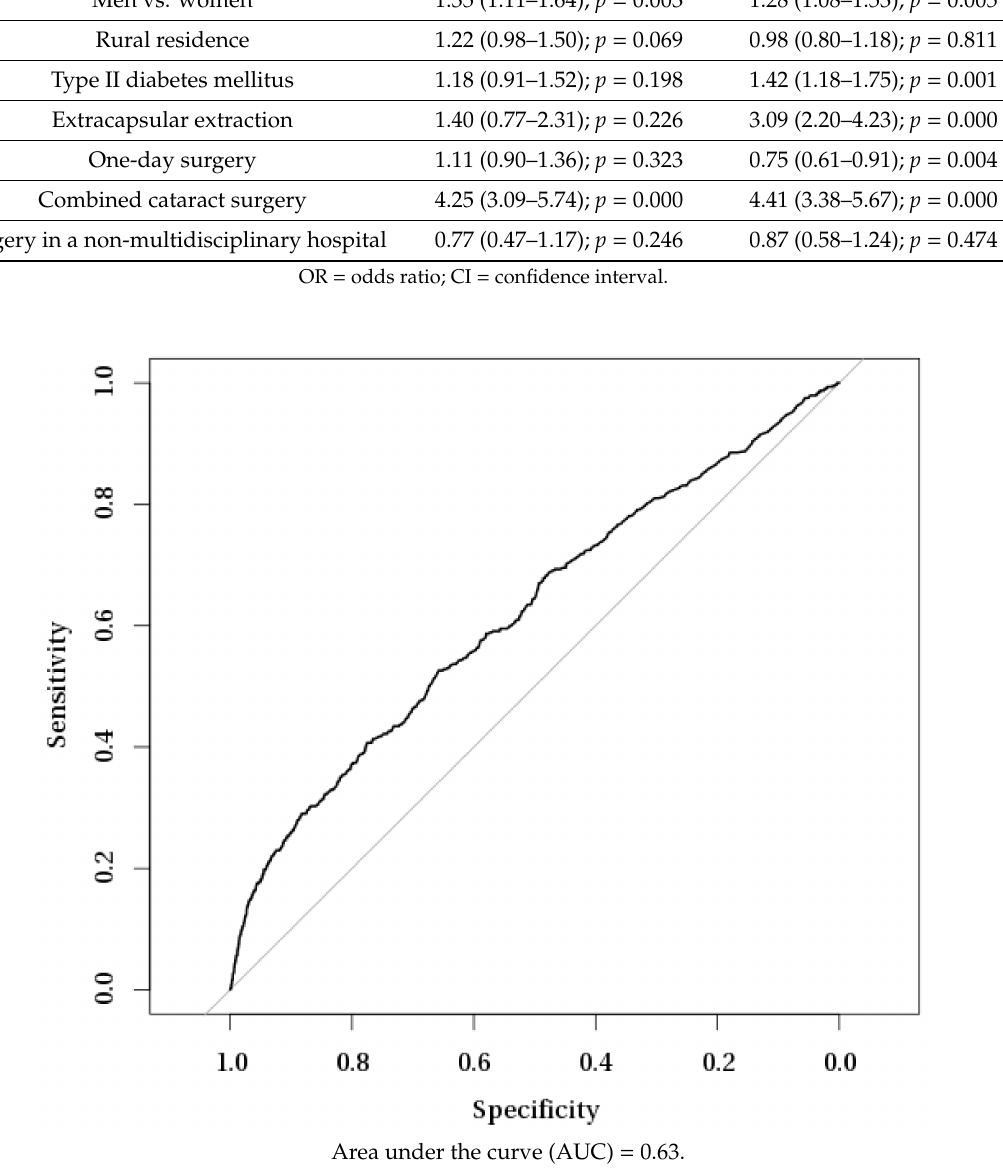
Figure 2. Receiver operating characteristic (ROC) curve analysis of sensitivity / specificity evaluation of multiple logistic regression model for acute postoperative